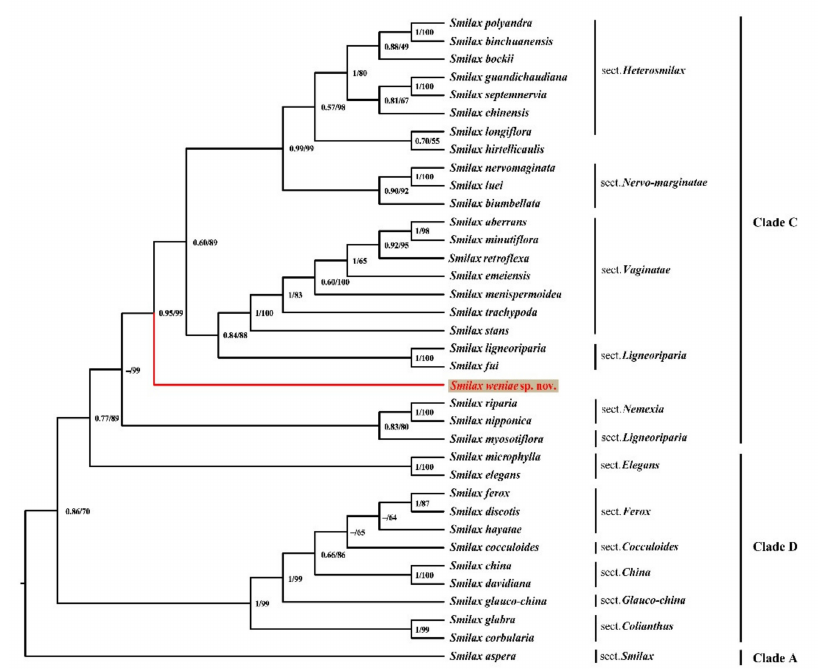
Figure 1. Maximum likelihood cladogram of the ptDNA of Smilax weniae and 34 other Smilax species, representing an Old World Smilacaceae clade. Posterior probabilities (PP > 0.50) and bootstrap values (BS > 50%) based on Bayesian and maximum likelihood (ML) analyses are shown near the branches. Clade information adopted from Qi et al. [1].